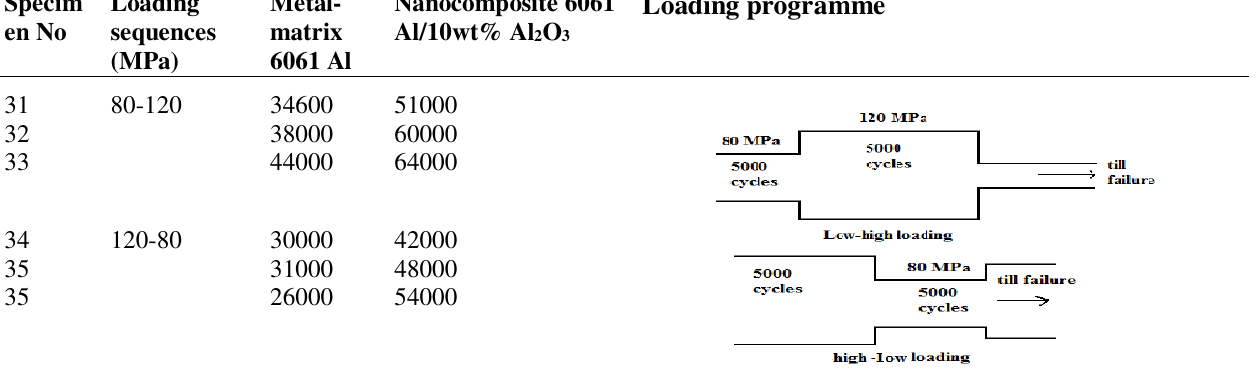
Cumulative fatigue results for metal-matrix and nanocomposite (MMCs). Specim